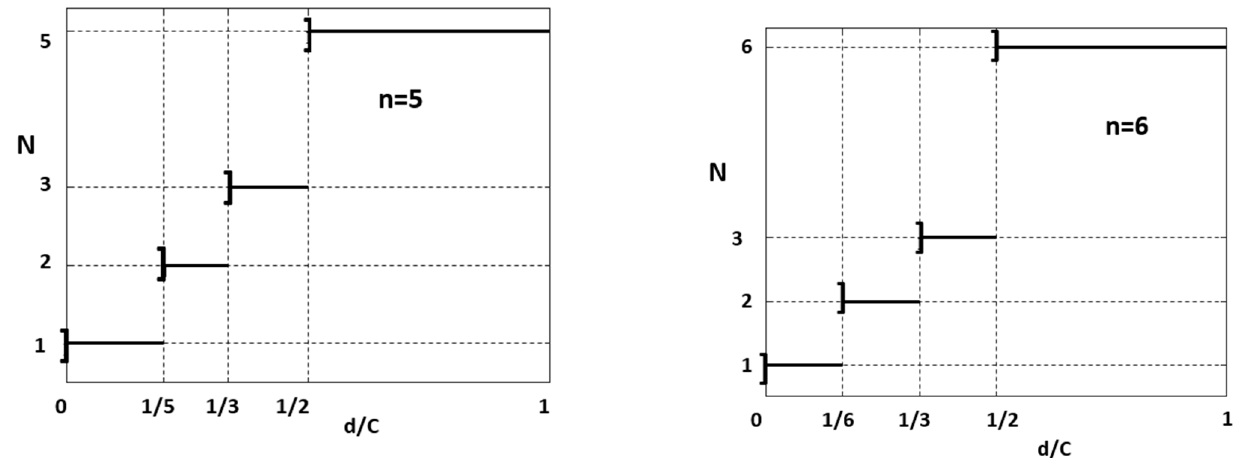
Figure A1. The variation of optimum number N of drones as function of vaccination centre demands, for n = 5, and 6.